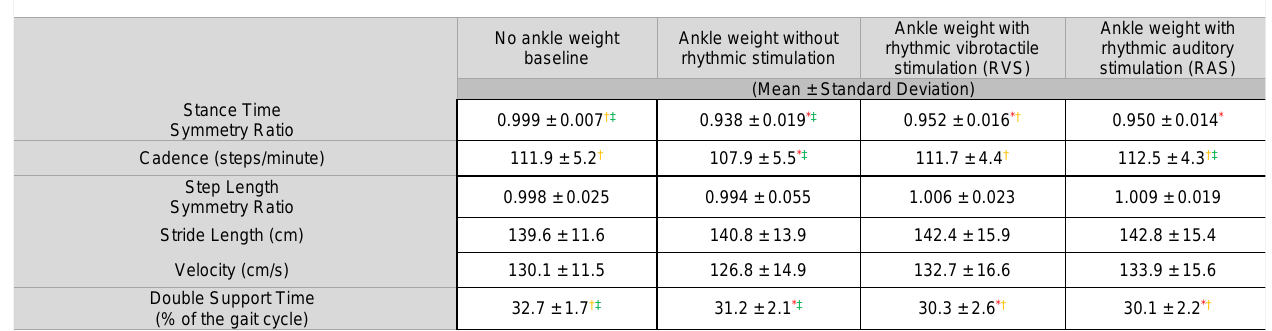
Table 2: Gait Parameters Under Different